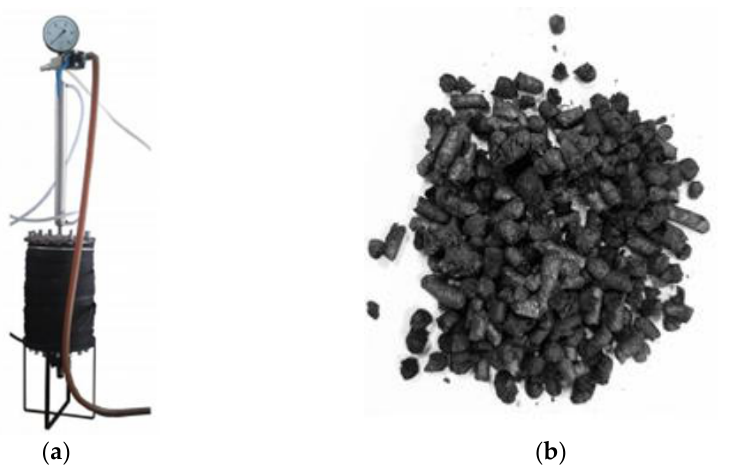
Figure 2. Electrically heated biomass and waste thermal reactor ( a ) and torrefied agricultural waste pellets ( b ).